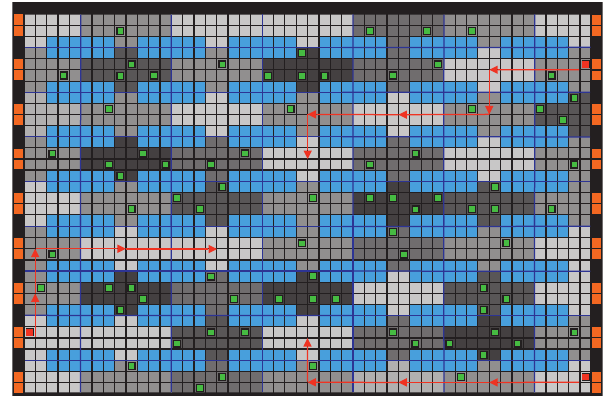
Figure 4: Illustration of the planning result in topology level. Red squares represent the robots which need to be planned. Green squares represent the other robots. The red line shows the planned passing order for each robot assigned with new task. According to the number of robots, the grey shade implies the crowdedness of each district. The fewer the number of robots, the lighter the